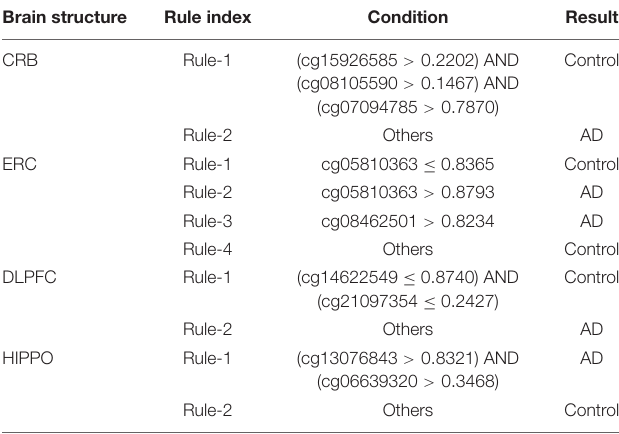
TABLE 3 | Classification rules generated by PART for four brain